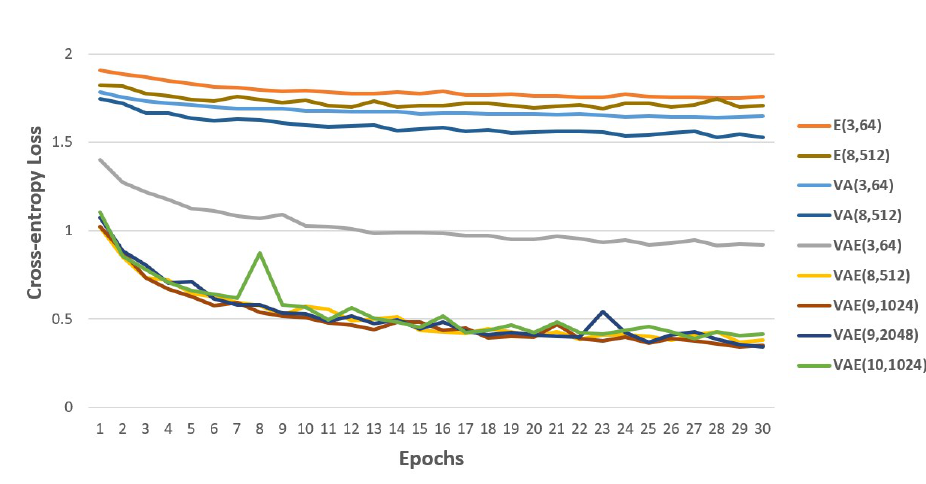
Figure 10. Cross-entropy loss on validation set of the proposed SFER model